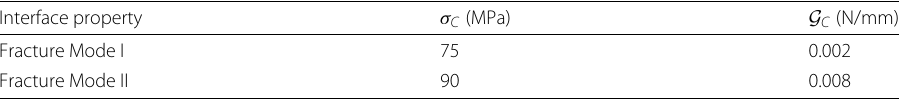
Table3 Mechanical properties of the fibre–matrix interface Interface